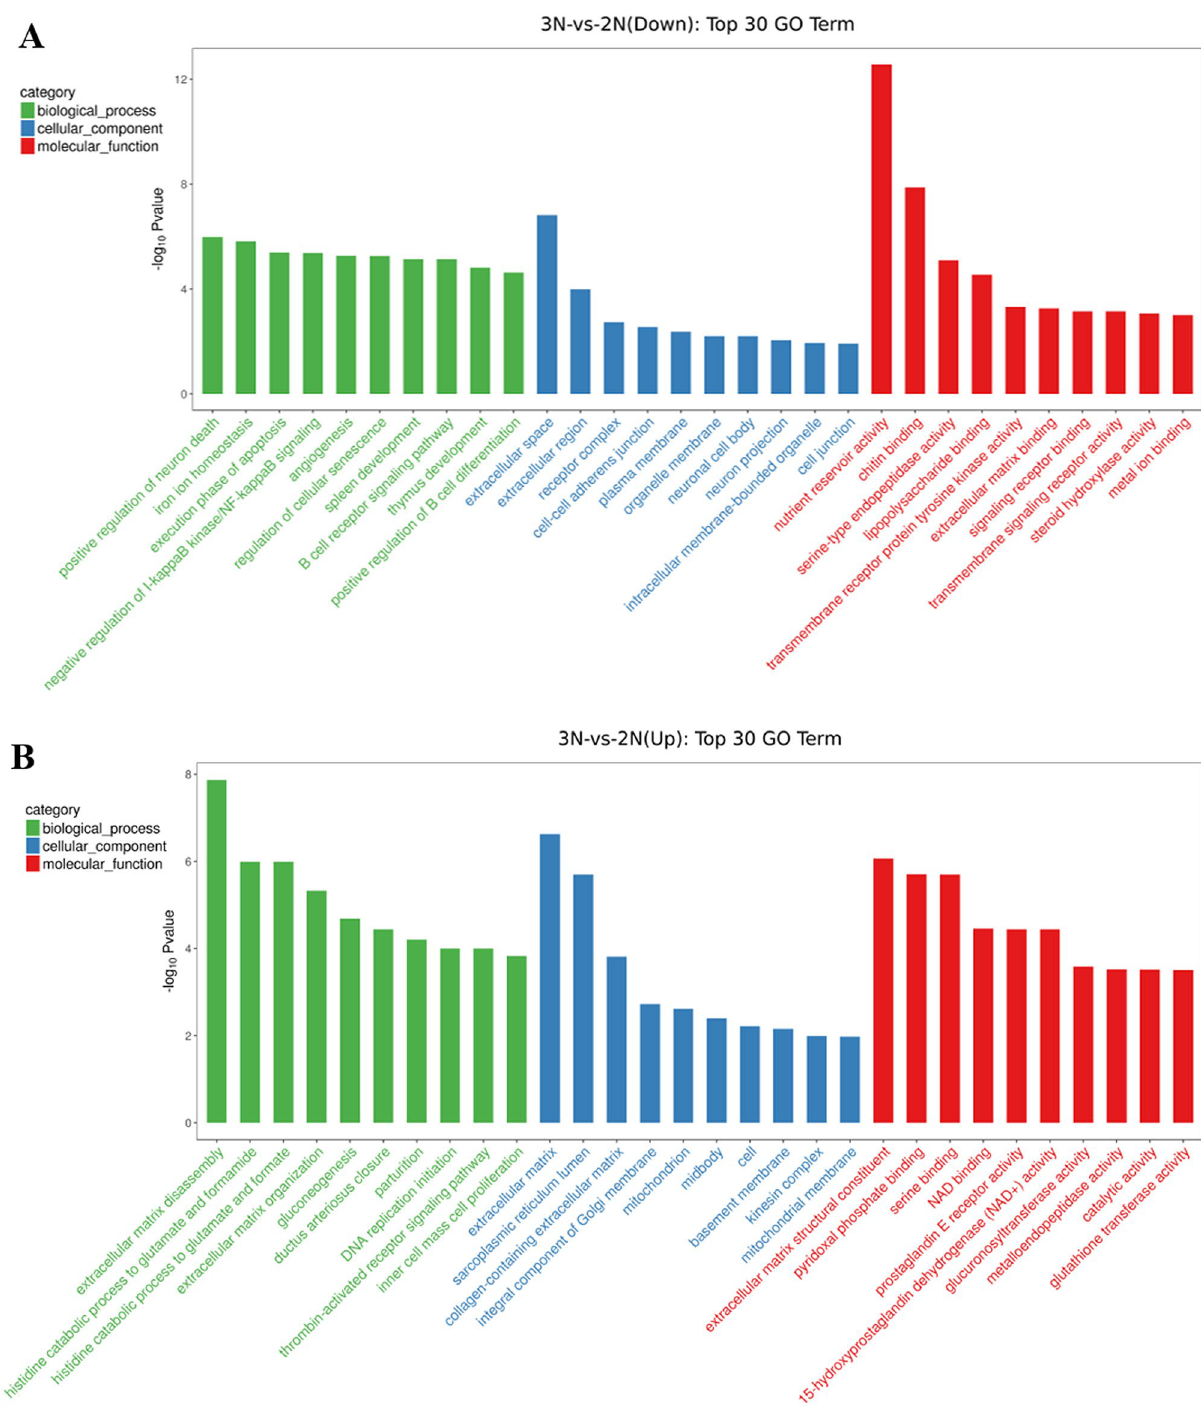
Figure 3. GO enrichment analysis of the top 30 differentially expressed genes. The X-axis is the GO entry name and the Y-axis is -log10 p -value ( A : down-regulated DEGs; B : up-regulated